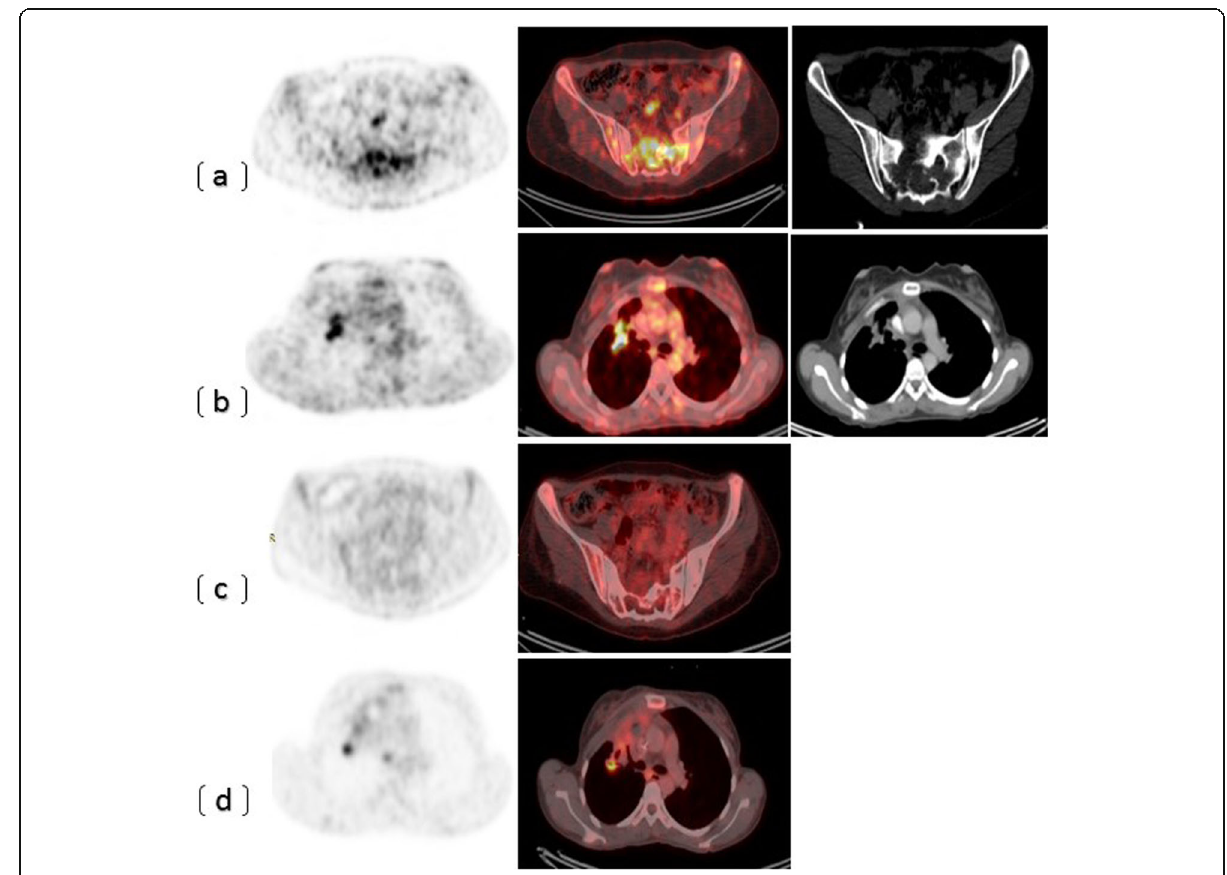
Fig. 8 A 27-year-old female patient with pathologically proven nodular sclerosis. Iliac crest BMB was negative. ( a and b ) Initial PET images, PET/CT fused images, and CT images in the axial plane showing FGD uptake at the sacrum with soft issue component and associated CT infiltrative lytic lesion ( a ). There is also pulmonary FDG uptake ( b ). Local biopsy from the sacrum was taken and confirmed BMI. ( c and d ) The post-treatment images showing complete metabolic resolution of the sacral lesion and the pulmonary nodule showed partial response with decrease in its